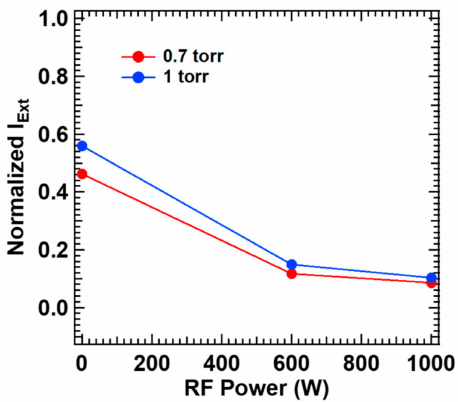
Figure 3. Normalized extinct laser power by propagation in the CVD chamber filled with N 2 , NH 3 and SiH 4 according to simultaneously driven RF